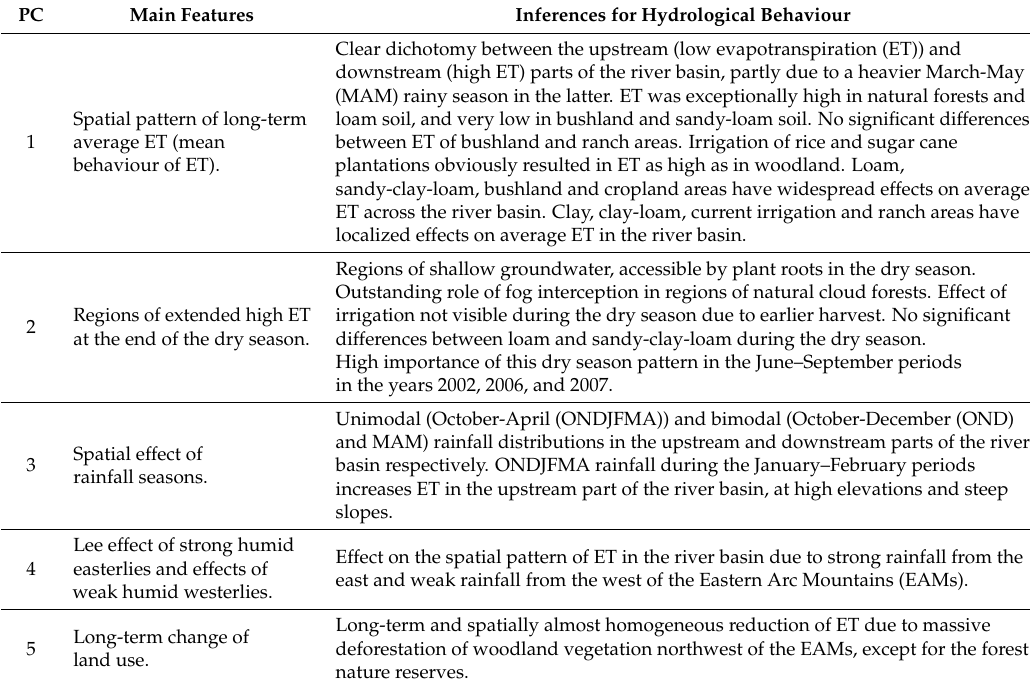
Table 4. Findings and inferences for water resources management and distributed hydrological